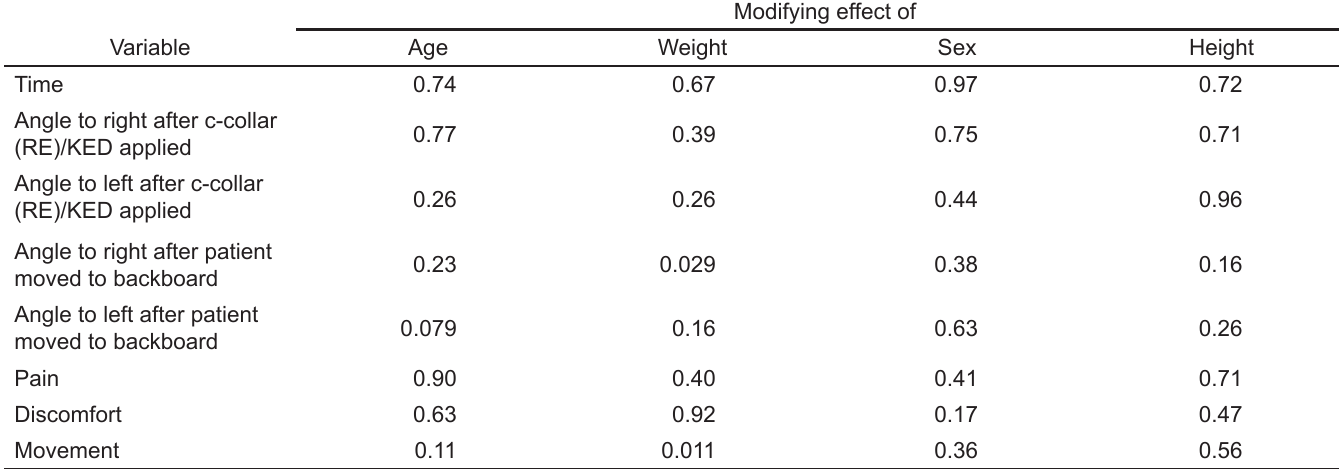
Table 2. P-values of regression analysis testing significant effects of age, weight, sex, and height as modifiers of the effect of using KED versus RE.